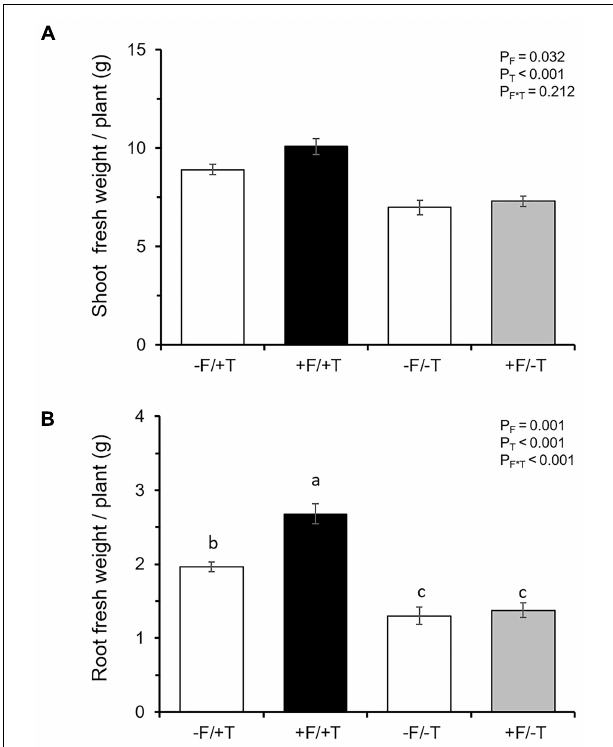
FIGURE 3 | Effects of spider mite infestation and tomato colonization by the endophyte Fusarium solani strain K (FsK) on plant growth parameters. One week after seed sowing plants were either inoculated with the endophyte (black and gray bars, +F) or not (white bars, –F). Subsequently, plants were either infested with 30 spider mites (10 mites per leaflet, 3 leaflets per plant, +T) or not (–T) when 4–5 weeks-old for a period of 10 days. Mean ± SE ( n = 8) of (A) shoot and (B) root fresh weight per plant across all treatments. Significant differences between treatments are indicated by different letters by Tukey’s post hoc tests after ANOVA: P <